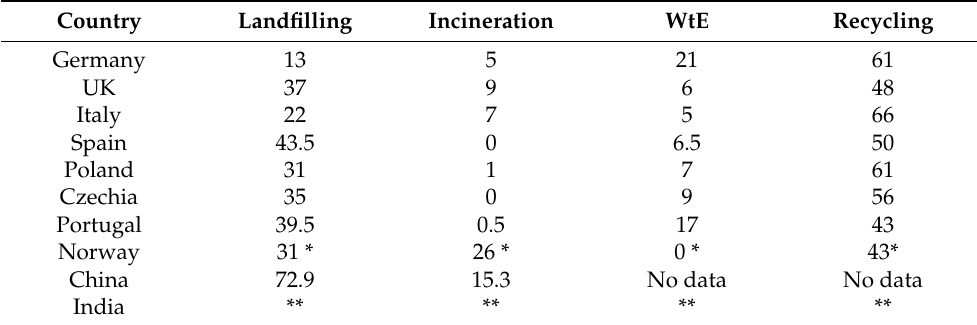
Table 31. Total municipal solid waste (MSW) split depending on the country and the management strategy or process chosen [66,84,85].